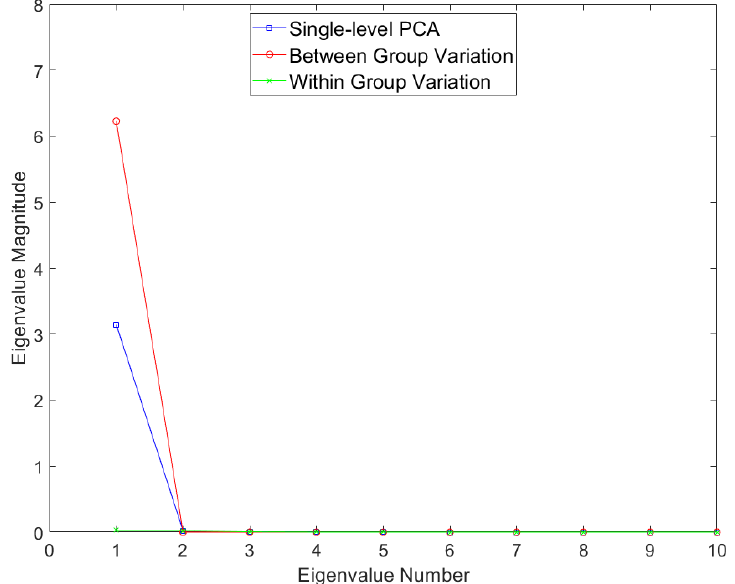
Figure 2. Eigenvalues for single-level PCA and mPCA for between-groups variation (level 1) and within-groups variation (level 2) for the Sine Wave dataset.